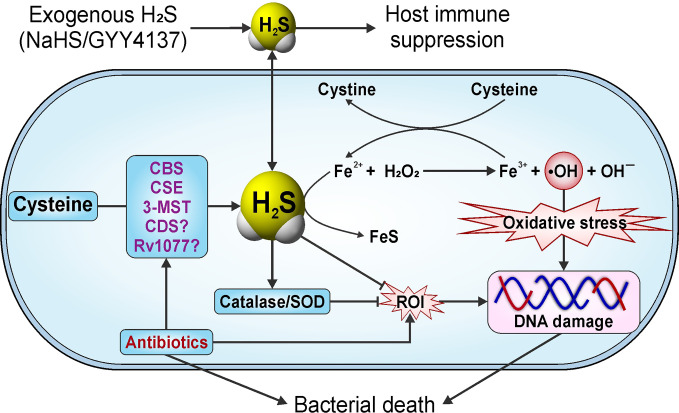
Endogenously produced H2S protects bacteria against oxidative stress. Endogenously produced or exogenous H2S protects bacteria from oxidative stress triggered by antibiotics and/or host against infection. This protection is achieved by multiple mechanisms: i) increased activity of H2S producing enzymes; ii) depletion of excess cysteine (cysteine generates Fe2+ for Fenton chemistry); iii) inhibition of the Fenton reaction, since H2S reacts with H2O2 and free Fe2+); iv) increased activity of catalase and superoxide dismutase (SOD); v) suppression of host immune responses. Question marks (?) indicate that the functions of CDS and Rv1077 in Mtb are unknown.